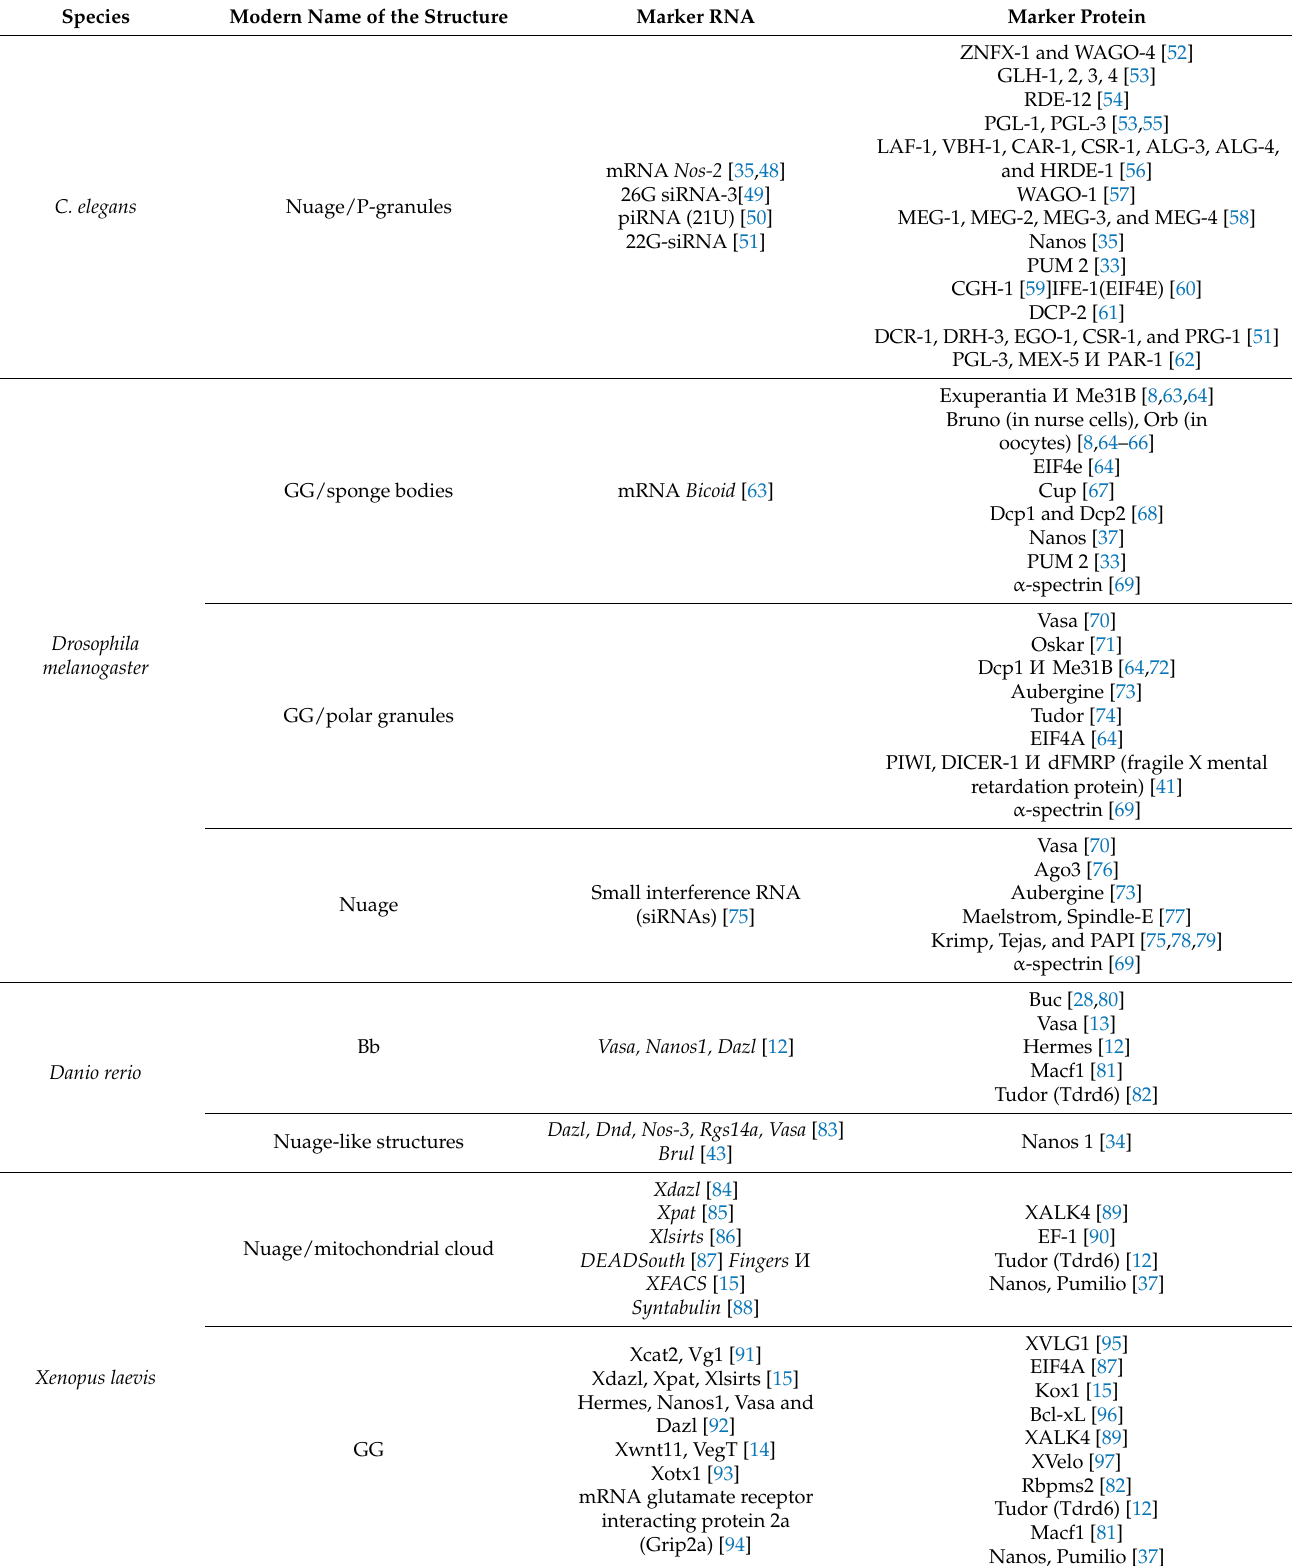
Table 2. Composition of GG in different